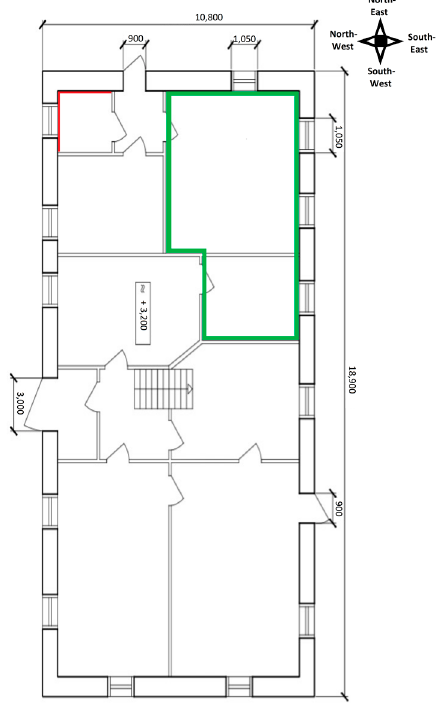
Figure 3. Inspected insulation on the ground floor in 2015: damaged floor and external wall insulation by martens (green) and a black layer of mold between the dolomite stone wall and mineral wool (red). Insulation of the basement ceiling with expanded clay (0.25 m, λ = 0.11 W/mK) in the green part in Figure 3.